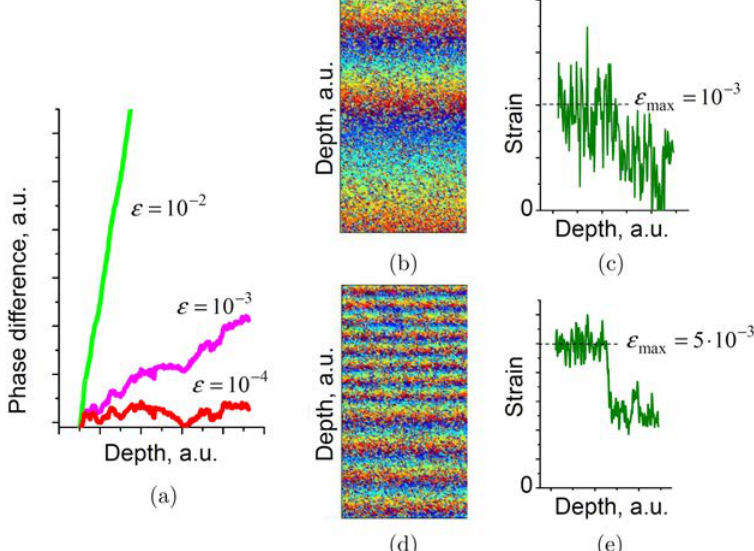
Fig. 5. Increased strain (but still below the onset of very strong decorrelation) is favorable for increasing e®ective SNR. The three curves in 1D schematic plot show (a) interframe phase di®erence as a function of depth for three di®erent strains (phase-di®erence slopes), but exactly the same numerically added noise, the masking in°uence of which signi¯cantly reduces with moderately increasing strain. Plots (b) and (d) show rigorously simulated (using model of Ref. 33) 2D phase-variation maps for maximal strains " ¼ 10 (cid:6) 3 and " ¼ 5 (cid:5) 10 (cid:6) 3 for a two-layer tissue with 50% contrast in sti®ness for the same level of the added noise (SNR (cid:3) 4.5 dB). Panels (c) and (e) are the corresponding vertical strain pro¯les to show that the e®ective SNR for ¯nding strain map is signi¯cantly better for " ¼ 5 (cid:5) 10 (cid:6) 3 than that for " ¼ 10 (cid:6) 3